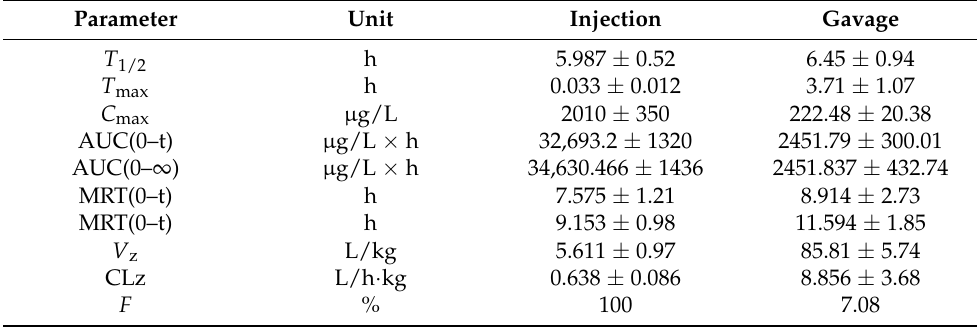
Table 5. Blood concentration of Hou after a single administration of HEO by different administration forms ( n =